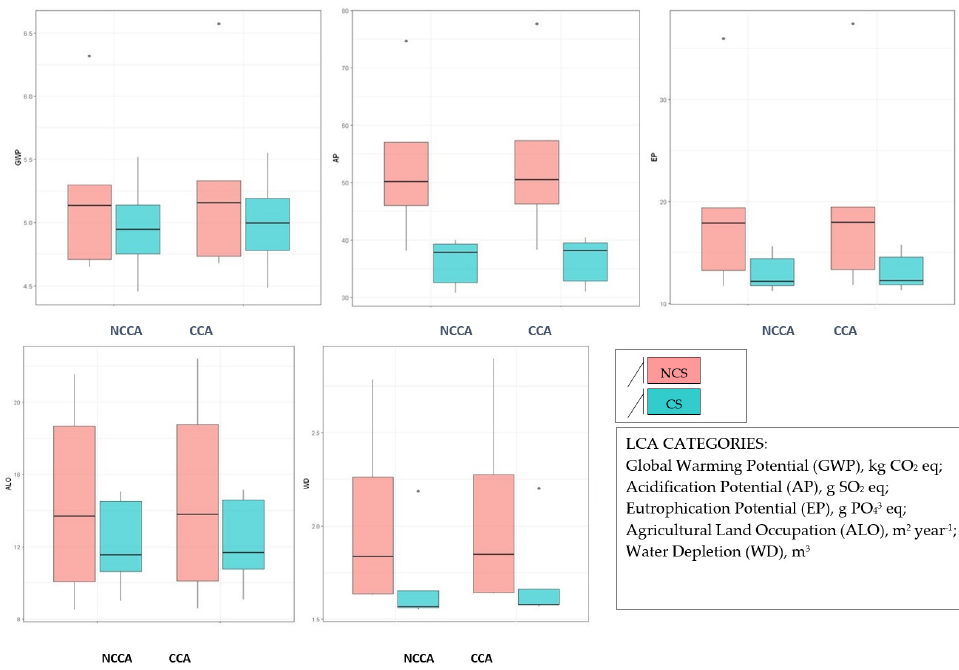
Table 7. Distribution of LCA categories in the comparison between non-corn silage (NCS) and corn silage (CS) system. No and Culled Cows Allocation (NCCA and CCA) results are also shown by box plots.